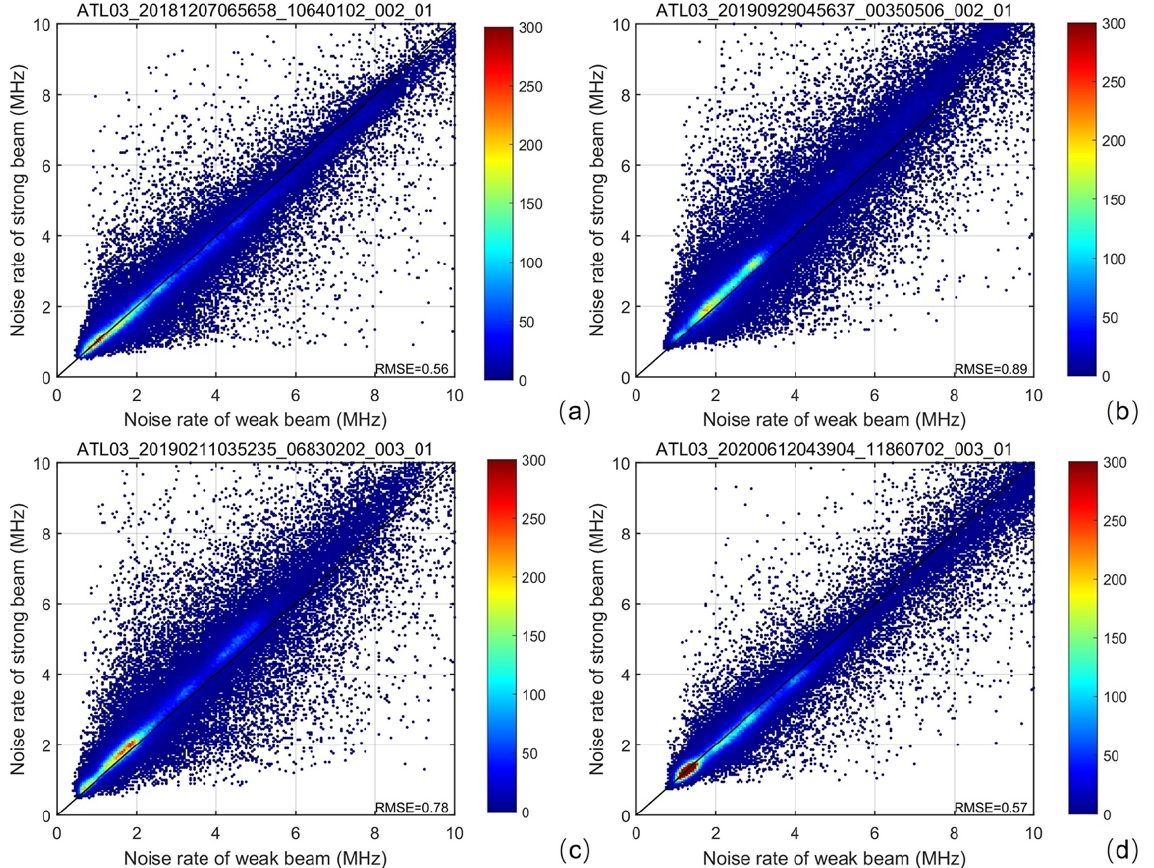
Figure 11. ( a – d ) Heat maps of background noise rates from the strong beam and weak beam in the same pair in four study areas. The abscissa and ordinate correspond to the noise rates from the weak beam and the strong beam data. The number of data at certain coordinates is marked with different colors and the color bar gives the data number.